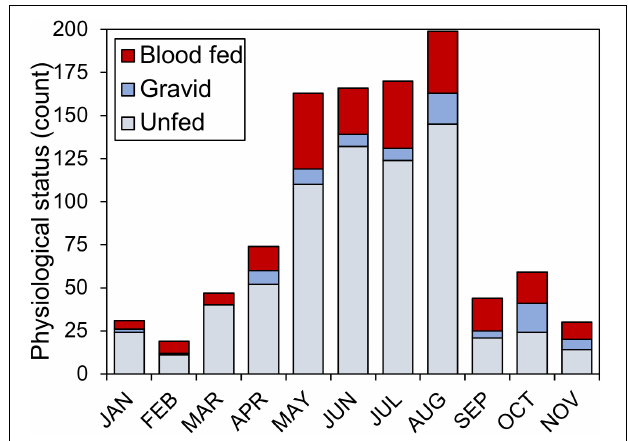
FIGURE 2 | Physiological status of Cs. melanura females from Central Florida. Females were sampled using resting shelters at 12 total sites in Orange and Polk County, FL, United States, in 2018.